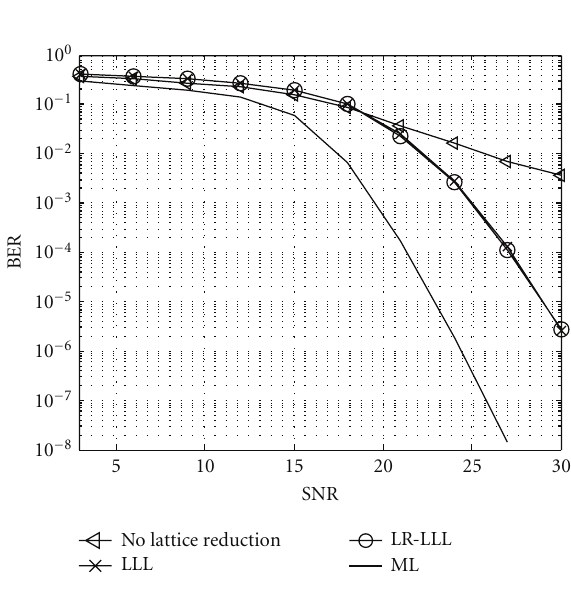
Figure 2: BER versus SNR of the 4 × 4 QR-SIC MIMO detectors using di ff erent lattice-reduction algorithms. Figure 3: BER versus SNR of the 8 × 8 QR-SIC MIMO detectors